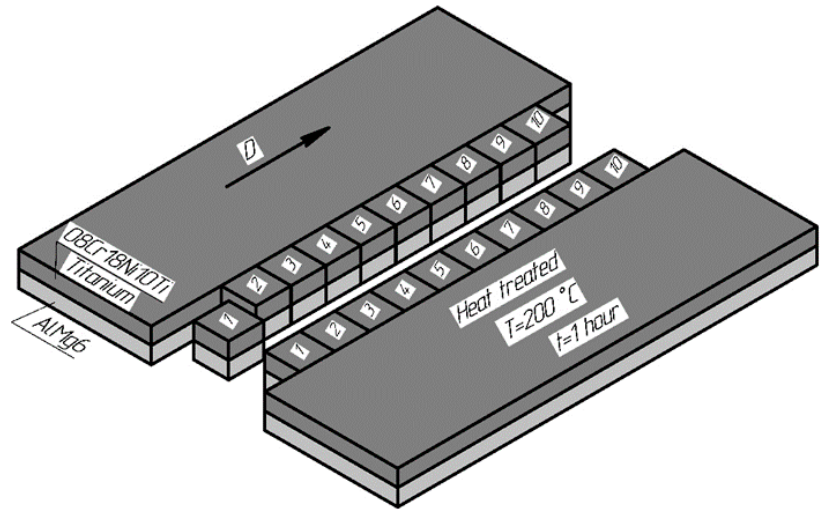
Figure 2. Preparation of tear strength specimens.